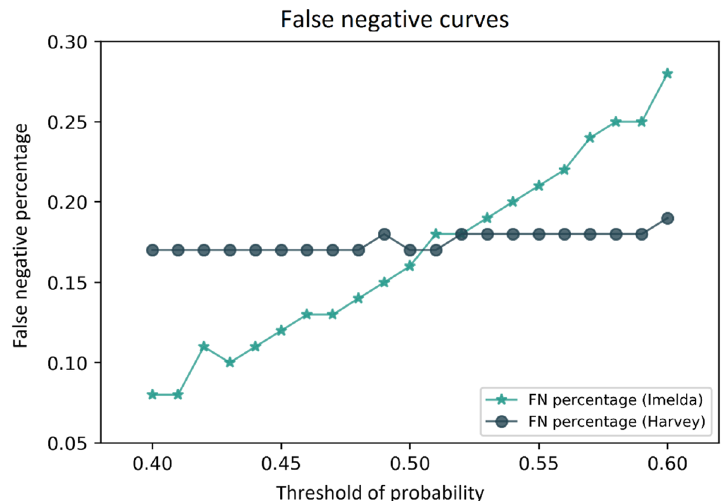
Fig. 5 False negative percentages from fivefold cross‑validation with random forest model by varying probability thresholds for Tropical Storm Imelda (green curve) and Hurricane Harvey (blue curve). FN means false